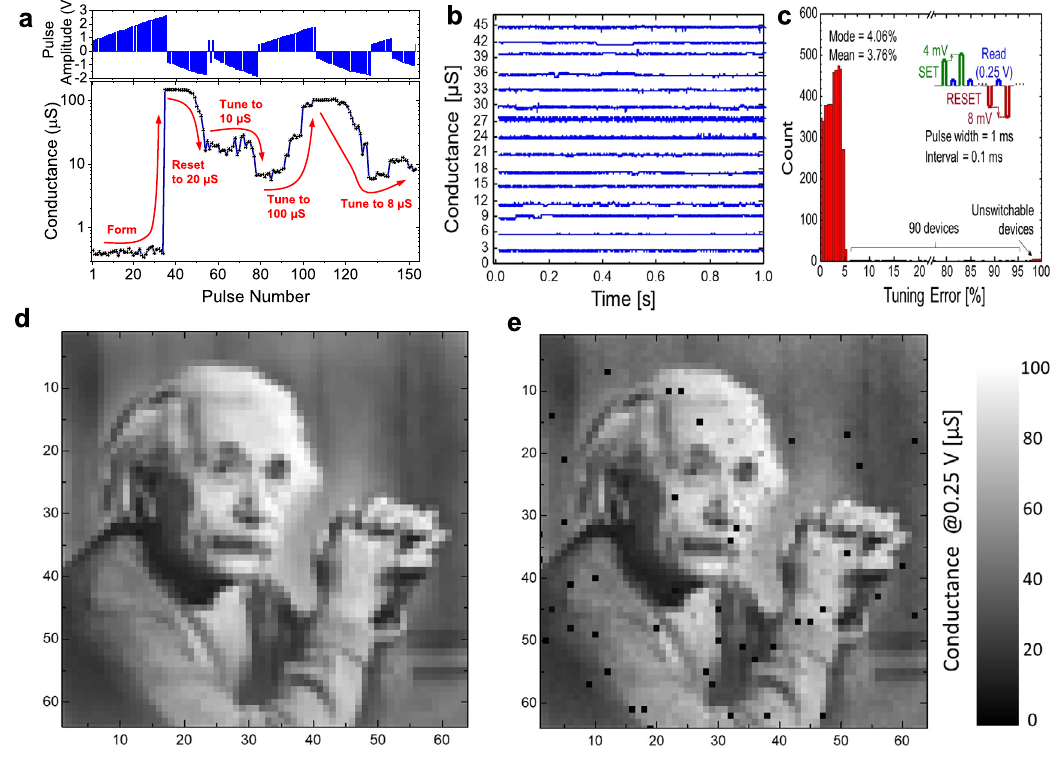
Fig. 3 Conductance tuning results. a Forming and high-precision tuning to 20 µ S, 10 µ S, 100 µ S, and 8 µ S target conductances of a crossbar device, with 1% relative precision. The inset shows the applied sequence of pulses during conductance tuning. Pulse sequences parameters are similar to those of panel c , except for the utilized 50 mV incremental step. b Example of device tuning with a 1% relative error to different conductance levels equally spaced from 3 µ S to 45 µ S. c – e Programming Einstein image to the 64 × 64 crossbar array with a 5% relative error. c Tuning statistics. Inset shows details of the write- verify pulse sequence. d The target device conductances in the range of 10 µ S to 100 µ S corresponding to the gray-scale quantized image and ( e ) their actual measured values after completing automated tuning. The relative tuning error is de fi ned as 100% × | I target (0.25 V) − I actual (0.25 V) | / I target (0.25 V). All conductances are speci fi ed at 0.25 V. Einstein image copyright by Yousuf